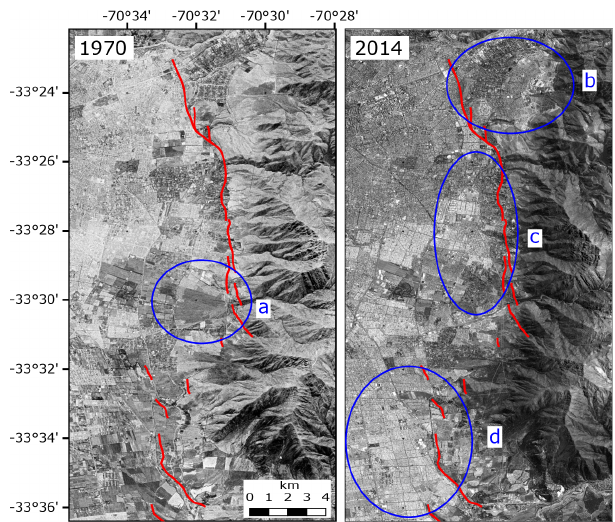
Figure 1. Declassified corona satellite image ( ∼ 2m resolution) from 1970 (left) and the same region in the SPOT imagery (1.5m resolution; right) used in this study showing the eastward expan- sion of the city over the San Ramón Fault (red lines). Four notable regions are highlighted in blue: (a) an alluvial fan that is clearly visible in the older imagery but completely covered with buildings in the recent image, (b) expansion into the foothills of the moun- tain and onto the hanging wall of the San Ramón thrust fault (these are often more affluent neighbourhoods with better views across the city), (c) urban densification in the central regions, and (d) land use change from farmland to dense urban neighbourhood masking the fault